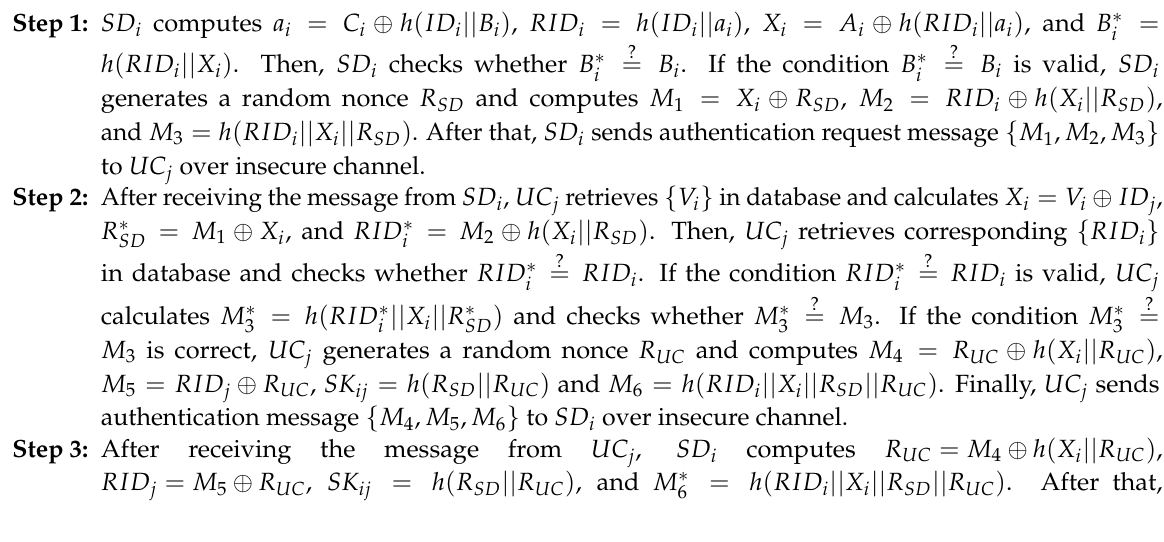
Figure 8. Authentication process of the proposed